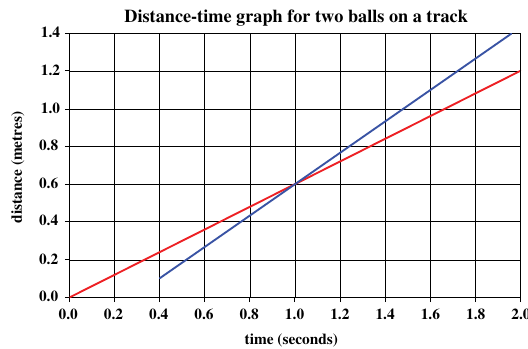
FIG. 5 (color online). Distance-time graph for two balls rolling along two parallel tracks.